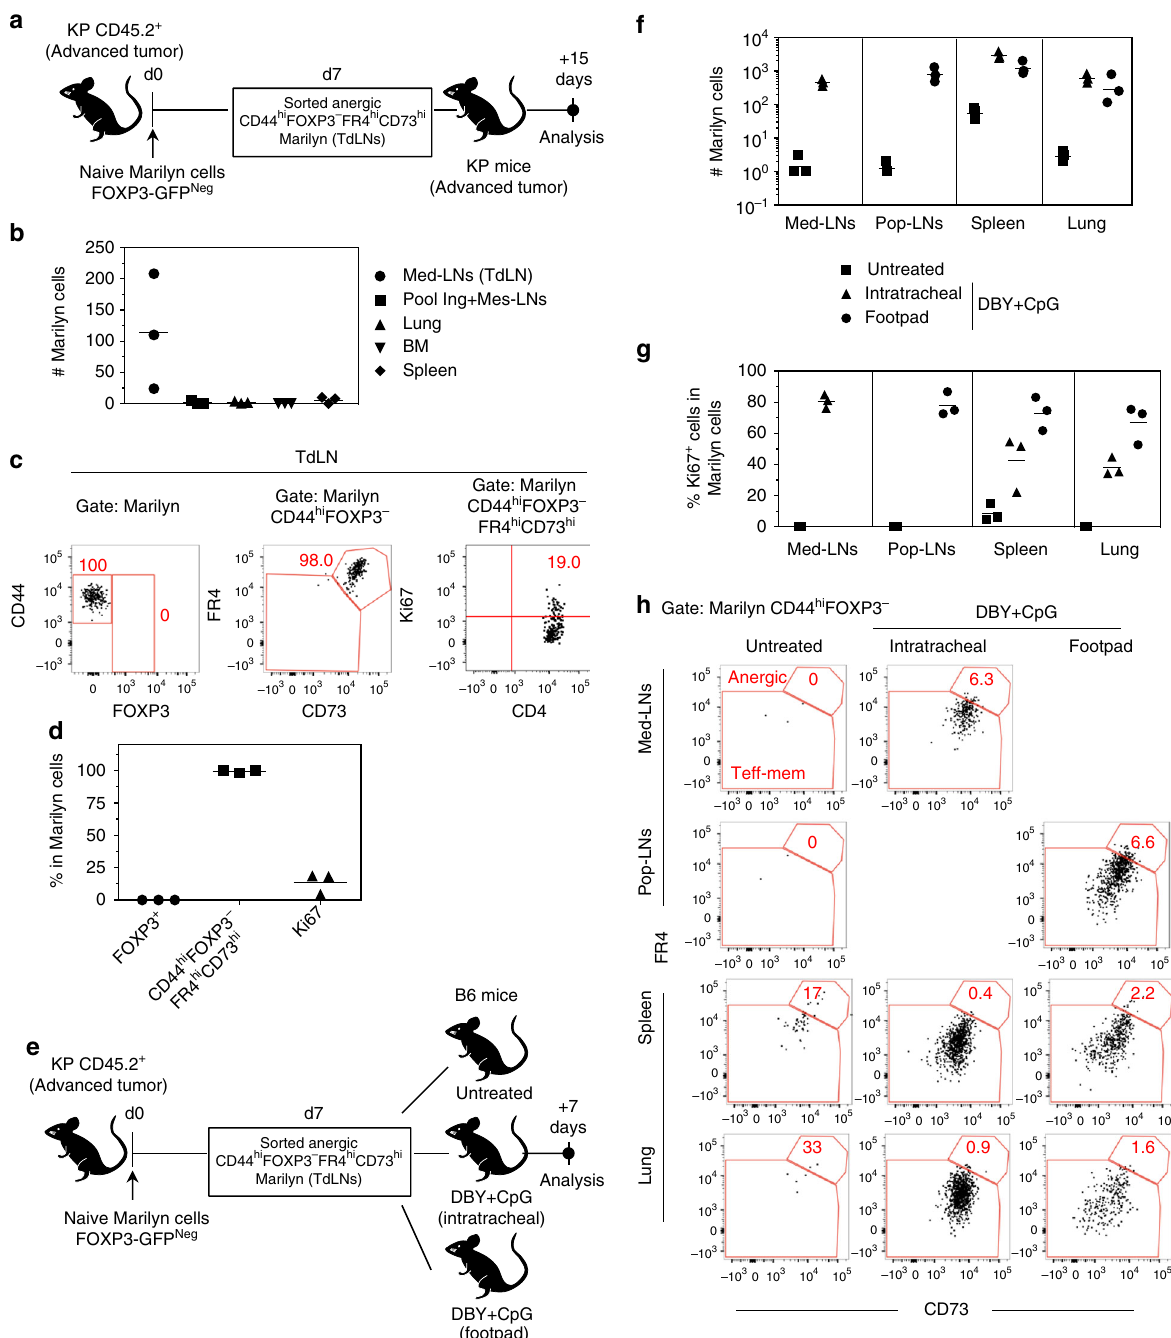
Fig. 4 The persistence of the anergic phenotype requires Ag restimulation in the tumoral context. a FACS sorted CD44 hi FOXP3-GFP neg FR4 hi CD73 hi Marilyn cells from TdLN of mice bearing advanced tumors were transferred into a second cohort of tumor-bearing hosts. b Number of recovered Marilyn cells in the indicated organs (inguinal (Ing) or mesenteric (Mes) LNs, lung, bone-marrow (BM) and spleen) and c , d phenotype of Marilyn cells 15 days after transfer. c Representative dot plots. d Quanti fi cation (frequency). e FACS sorted CD44 hi FOXP3-GFP neg FR4 hi CD73 hi Marilyn cells from TdLN of mice bearing advanced tumors were transferred into tumor-free mice left untreated or treated i.t. or f.p. with DBY peptide and CpG. f Number of Marilyn cells 7 days after transfer in Med or poplietal (Pop) dLNs, spleen and lung. g Frequency of Ki67 + cells among Marilyn cells. h Representative CD73 and FR4